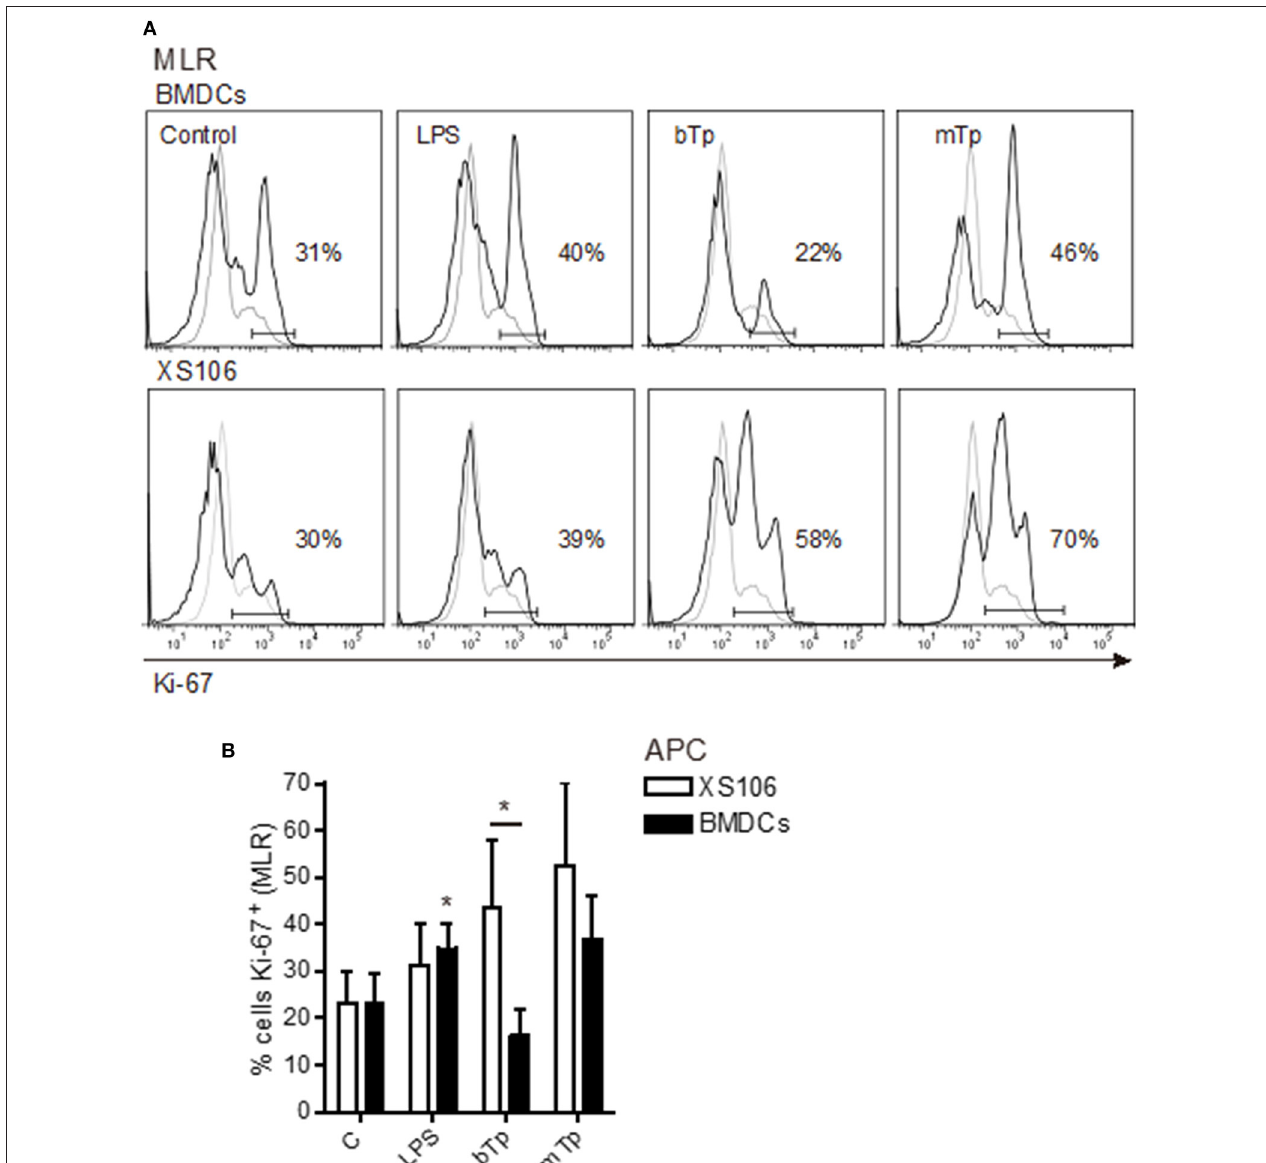
FIGURE 4 | T cell proliferation stimulated by BMDCs or XS106 cells conditioned by different infective stages of T. cruzi. BMDCs or XS106 cells were cultured with medium or different stimuli for 24h. Then, cells were washed, irradiated and cocultured with LN cells enriched in T-cells at 1:10 APCs:LN cells ratio for 3 days. Cell proliferation was assessed by intracellular detection of Ki-67 in T cells obtained from LNs by FACS. One independent experiment of three is represented by histograms. Gray lines show negative controls for the staining, while black lines correspond to cells stained with specific Ab (A) . Cultures were set up in triplicate, and results are expressed as the mean ± SEM (B) . * p < 0.05; two-way ANOVA and Bonferroni’s post-hoc